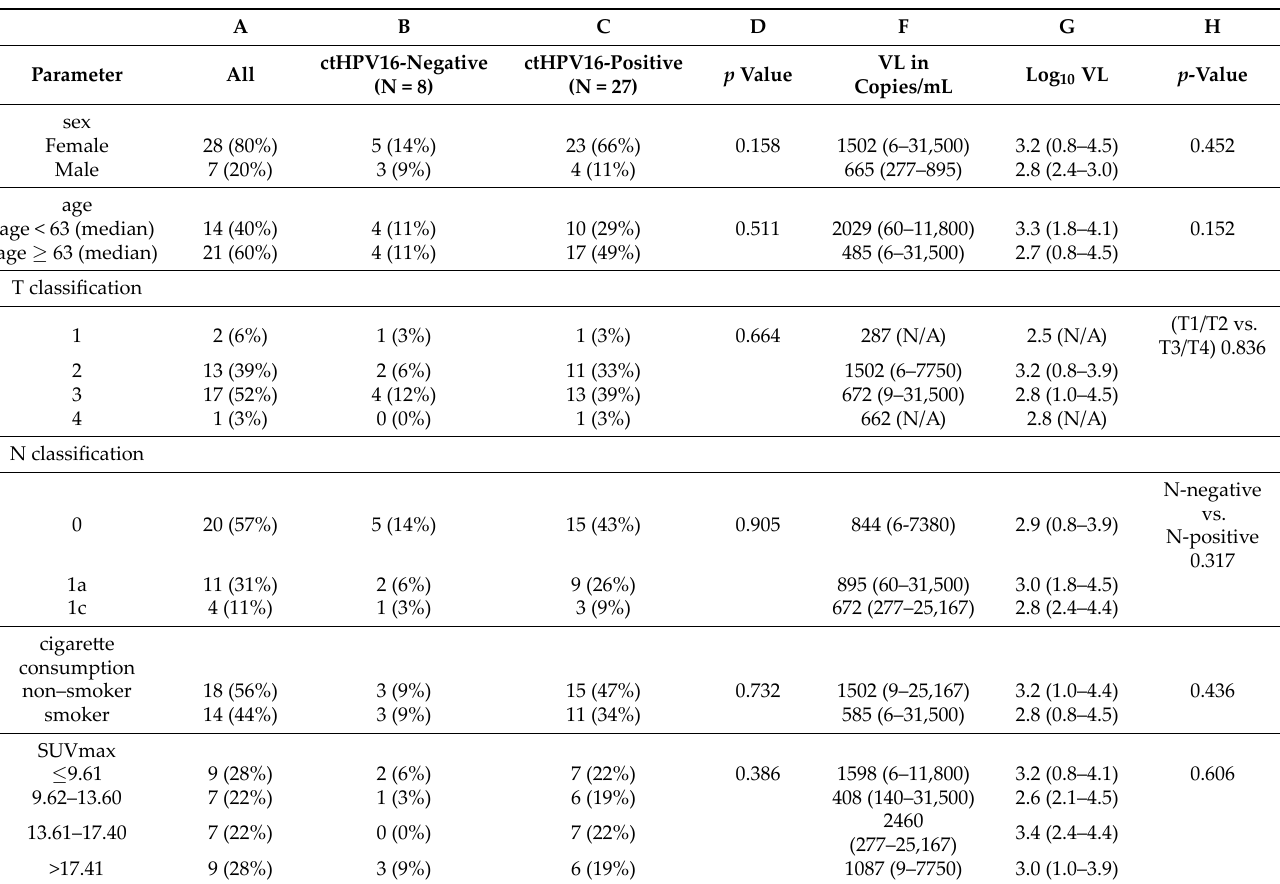
Table 2. Comparative analysis according to blood–based ctHPV16 status (column B–D). VL of ctHPV16 positive patients with ASCC (N = 27) (columns F–H) presented in crude data (column F) or log 10 (column